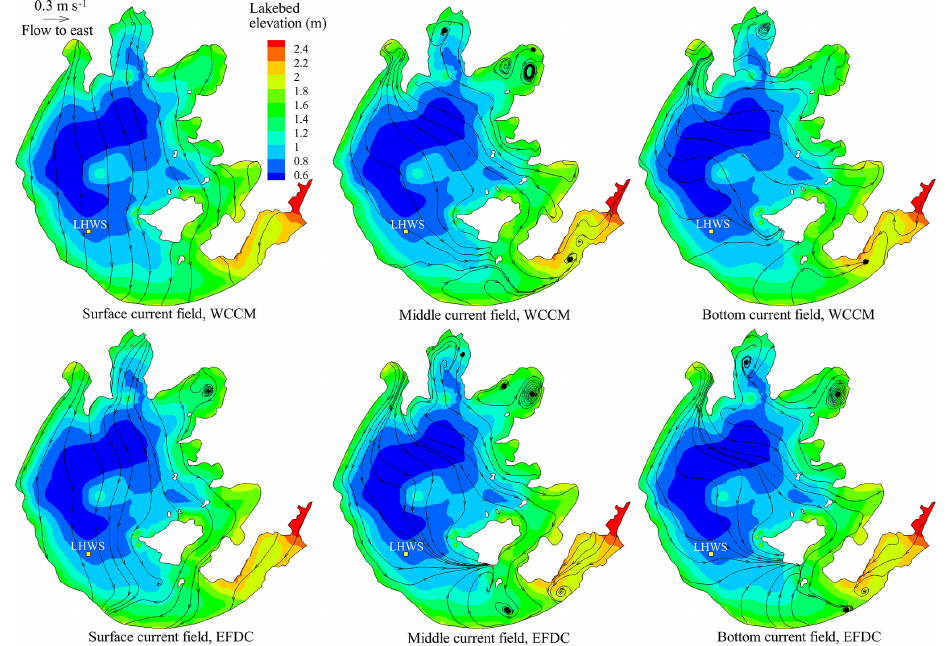
Figure B4. Comparison of the flow fields and stream traces in the surface, middle, and bottom layers of Lake Taihu simulated by the WCCM and EFDC at 22:00LT on 26 December